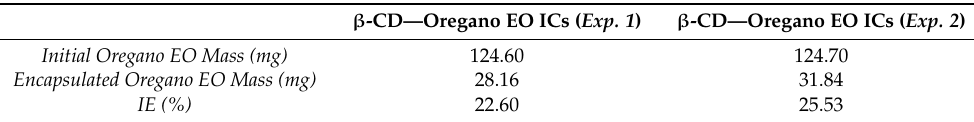
Table 3. Inclusion efficiency (IE) of the formed β -CD–oregano EO ICs. β -CD—Oregano EO ICs ( Exp. 1